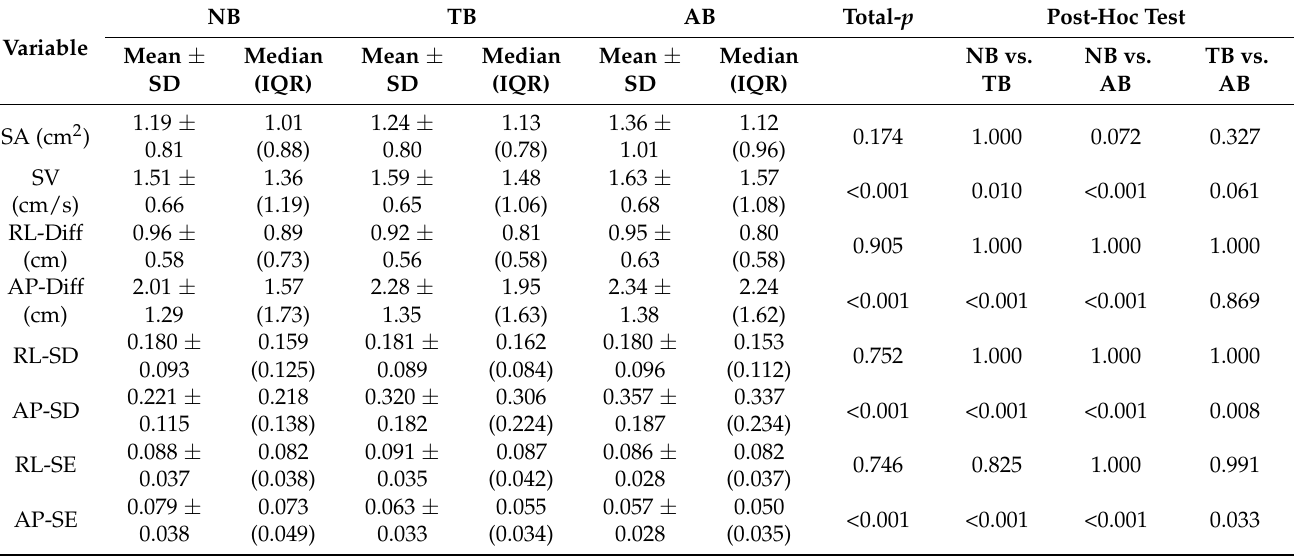
Table 4. Balance ability in double-leg stance.